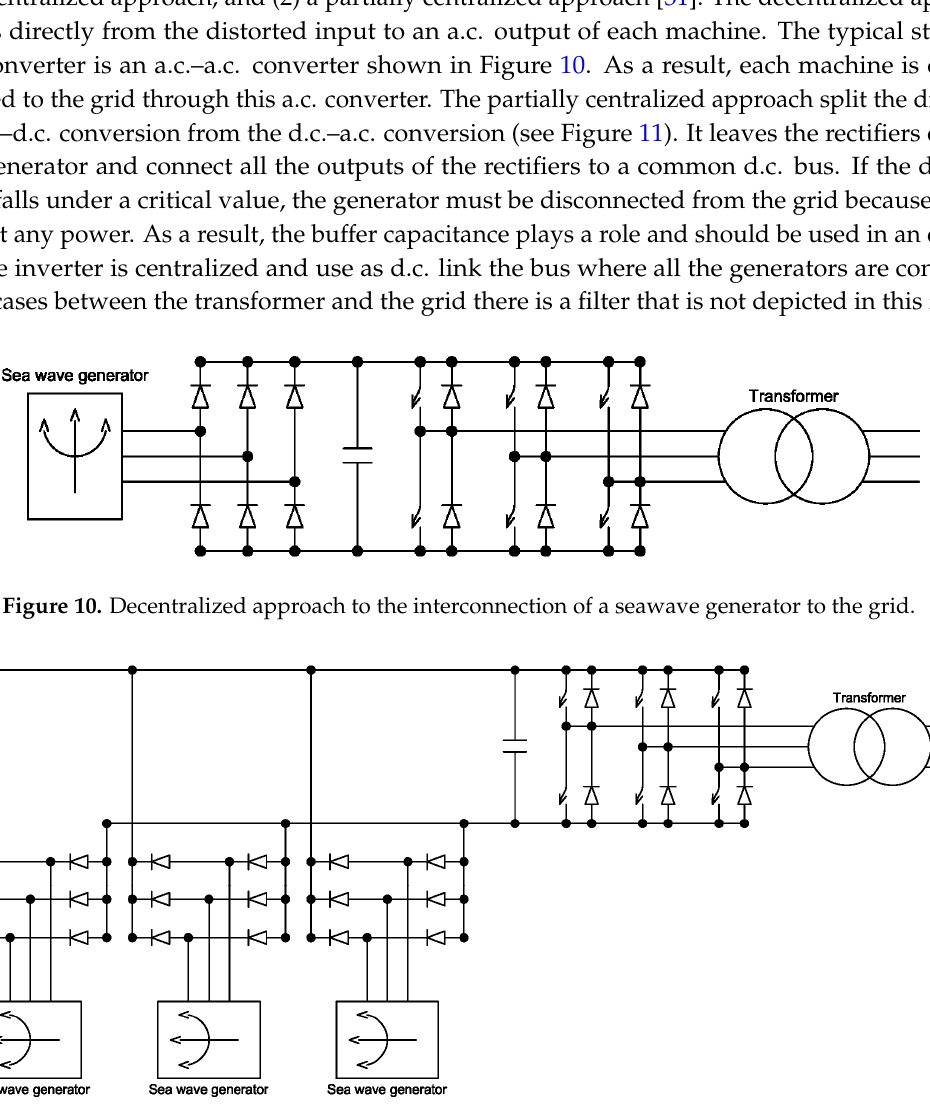
Figure 11. Partially centralized approach to the interconnection of several seawave generators to the grid.